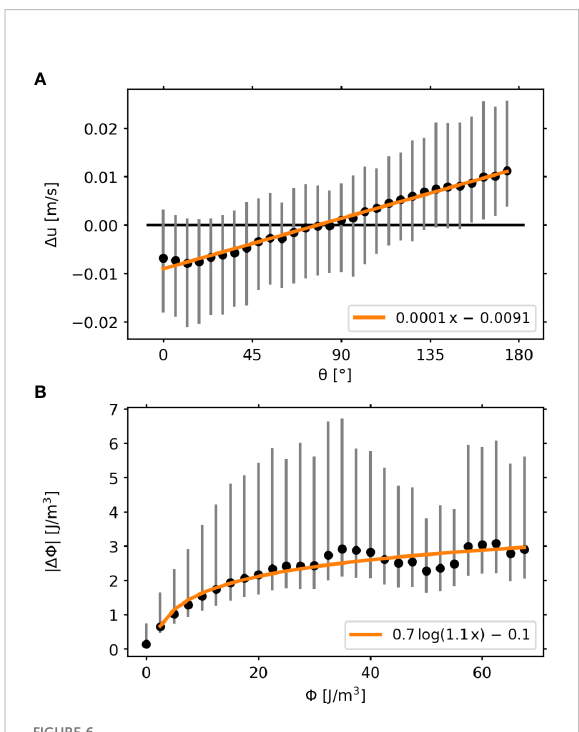
FIGURE 6 Correlations between the wind-tide alignment q and the associated wind wake effects in horizontal velocity u (A) , as well as between the potential energy anomaly F and associated absolute changes in potential energy anomaly F (B) . The data points correspond to hourly data between May and August 2013, interpolated in areas of minimum 0.01 m/s wind speed reduction, and averaged in 5° bins and 2.5 J/m 3 bins, respectively. Vertical gray lines show the standard deviation in each bin, whereas the orange lines show the respective fi t of the mean changes per bin (black